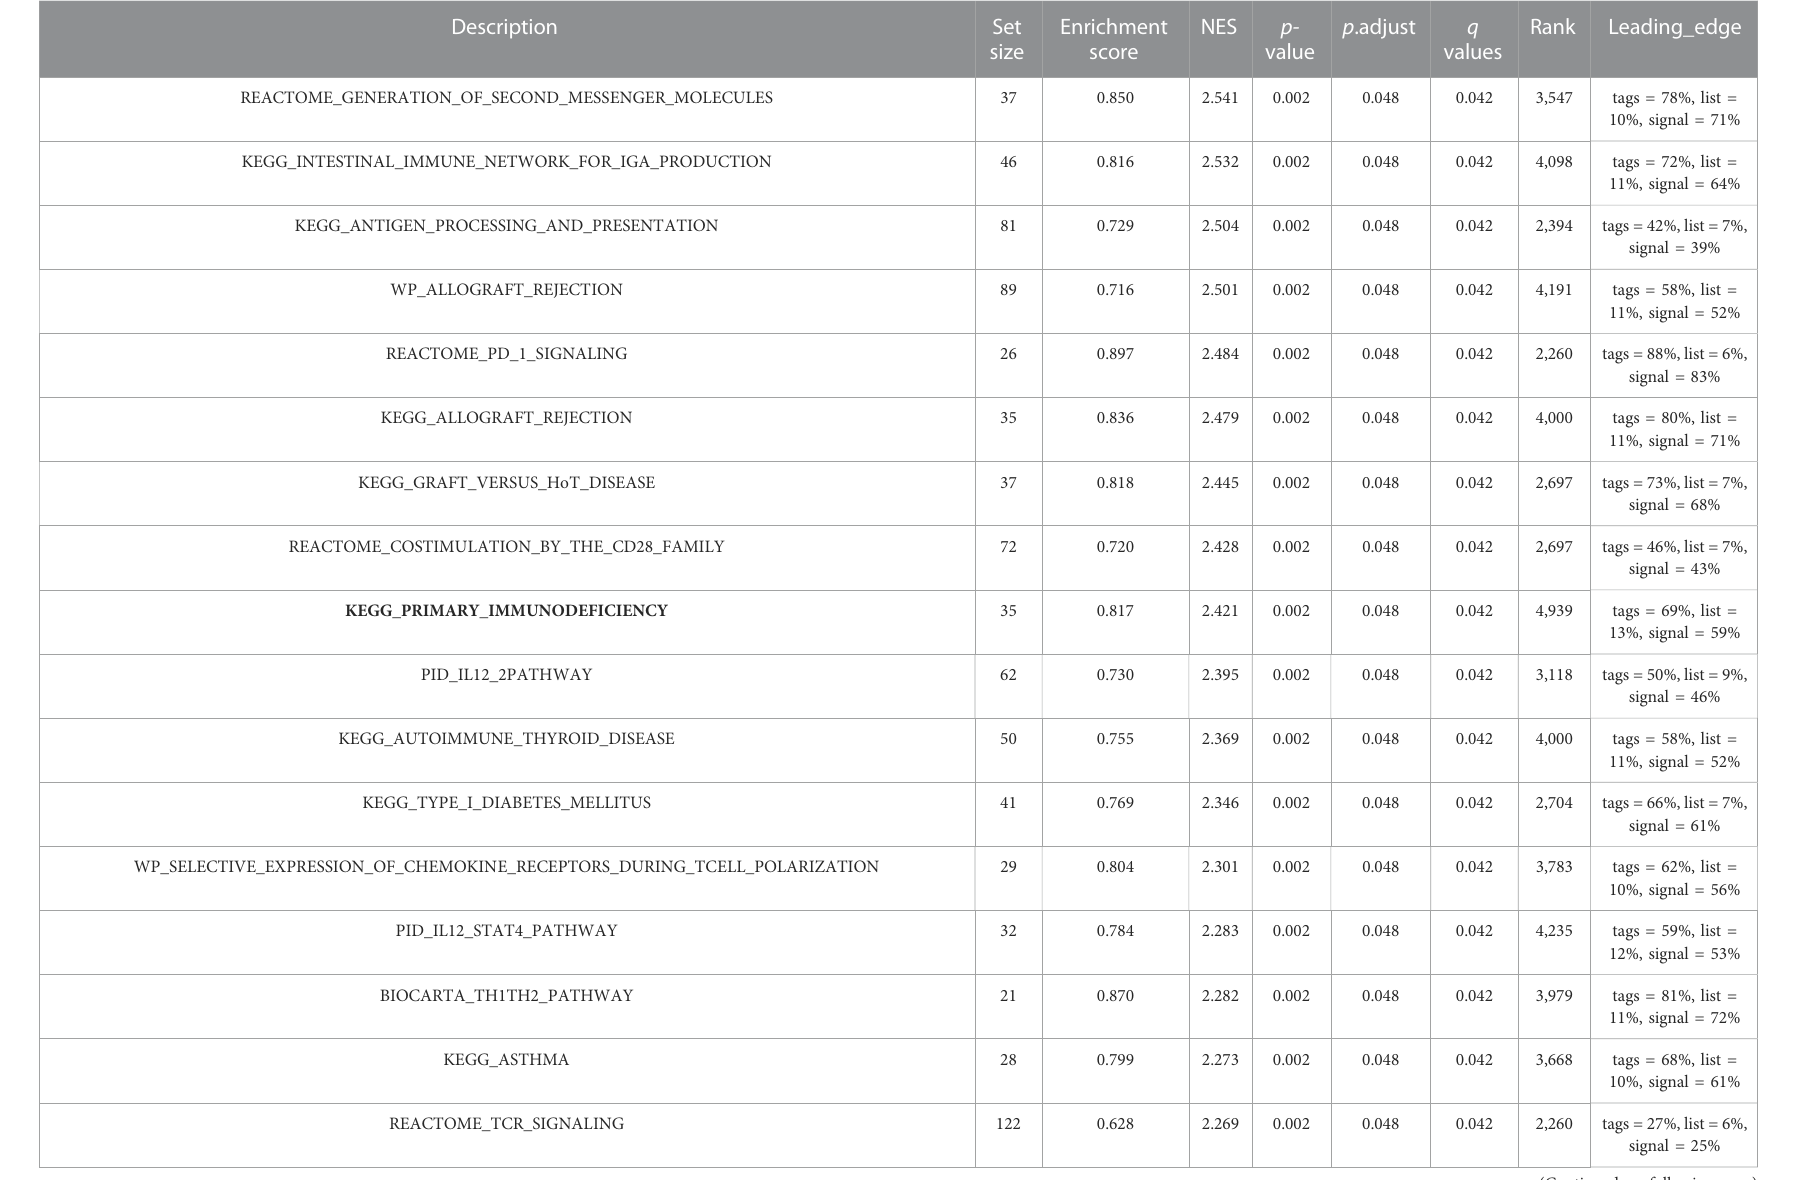
TABLE 5 The First Twenty positively correlated groups of gene set enrichment analysis (GSEA) based on their normalized enrichment score (NES) and p -value in HNSC.